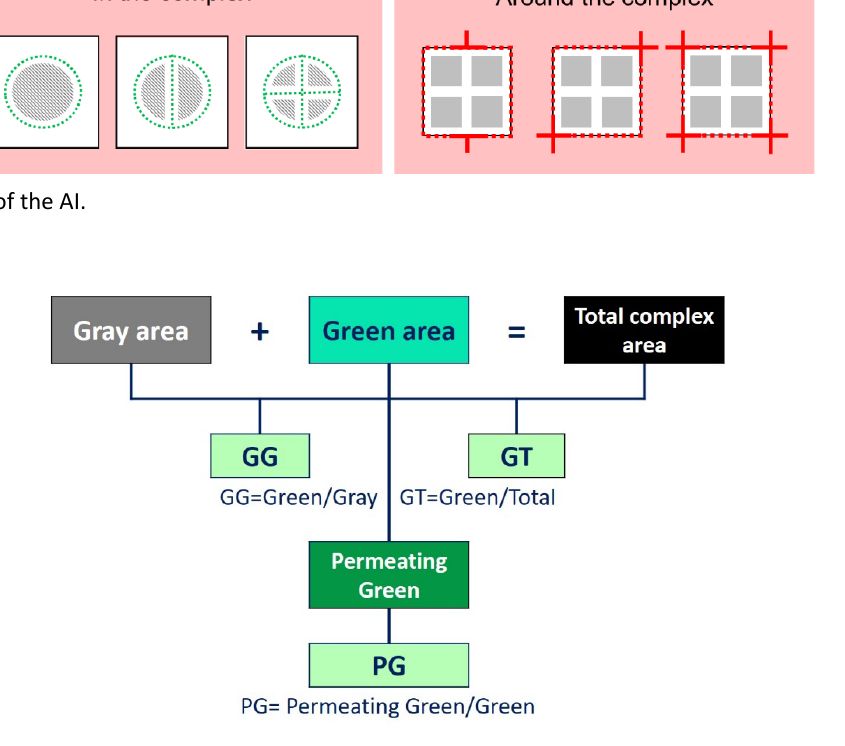
Figure 5. Parameters of the